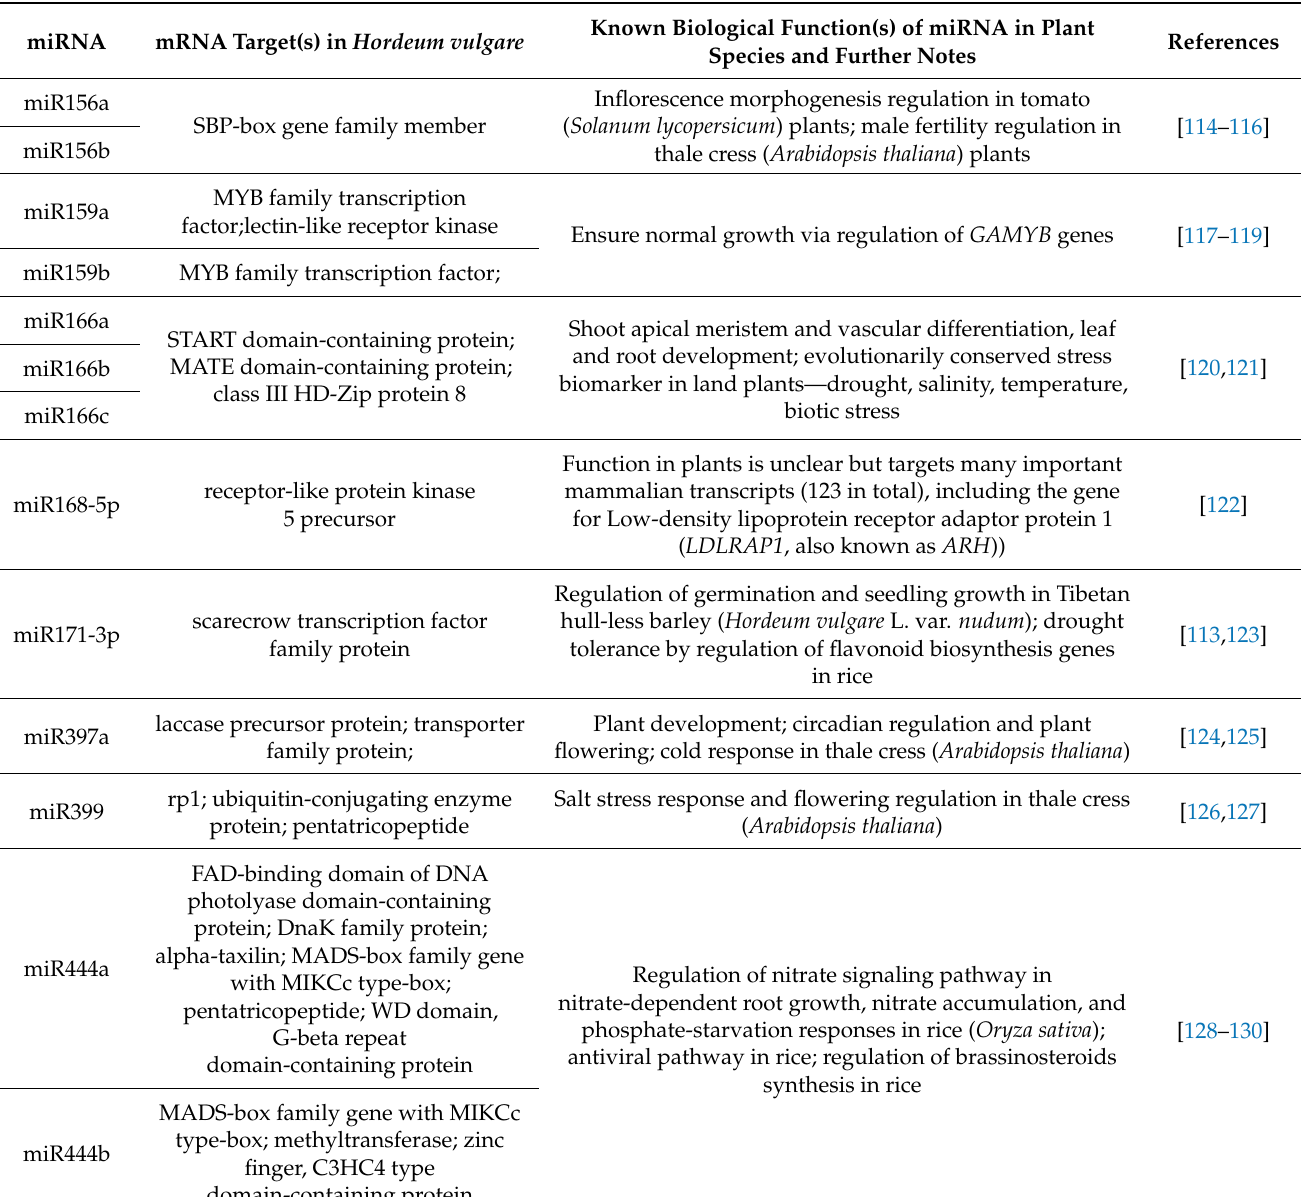
Table 3. High-confidence miRNA targets in Hordeum vulgare together with their experimentally verified or supposed biological functions in higher